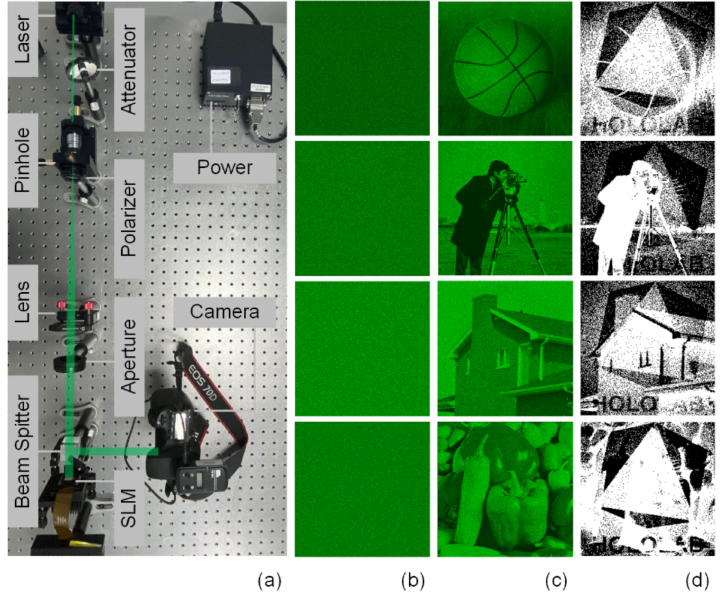
Figure 7. ( a ) The optical experimental system. ( b ) The reconstructions of encrypted CGHs. ( c ) The reconstructions of decrypted CGHs. ( d ) The extracted watermarks from the